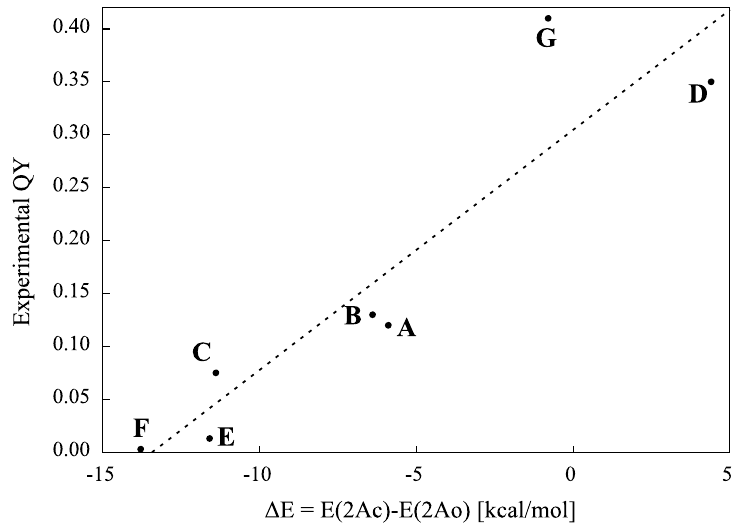
Figure 4. Correlation of experimental QY with calculated ∆ E = E(2Ac) − E(2Ao). The C F parts were truncated in the calculations, the level of which was 5 6